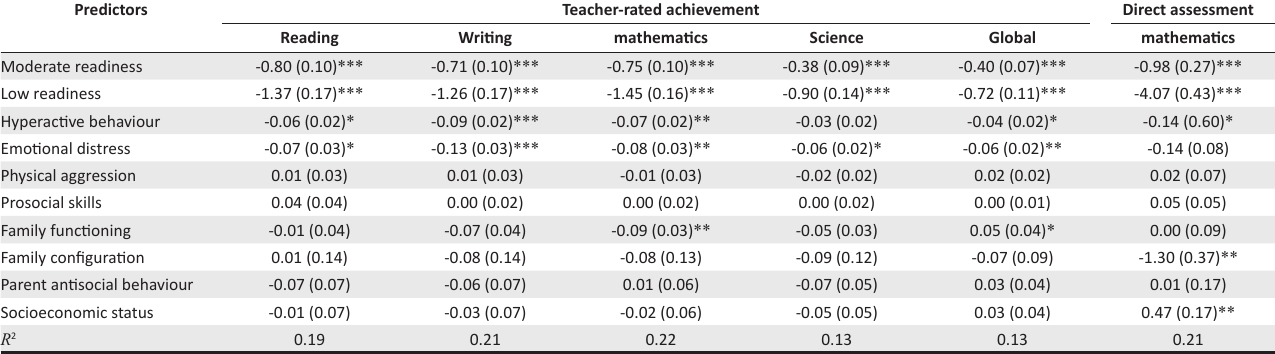
TABLE 3: Unstandardised regression coefficients reporting the relationship between kindergarten school readiness profile membership and fourth-grade academic adjustment.